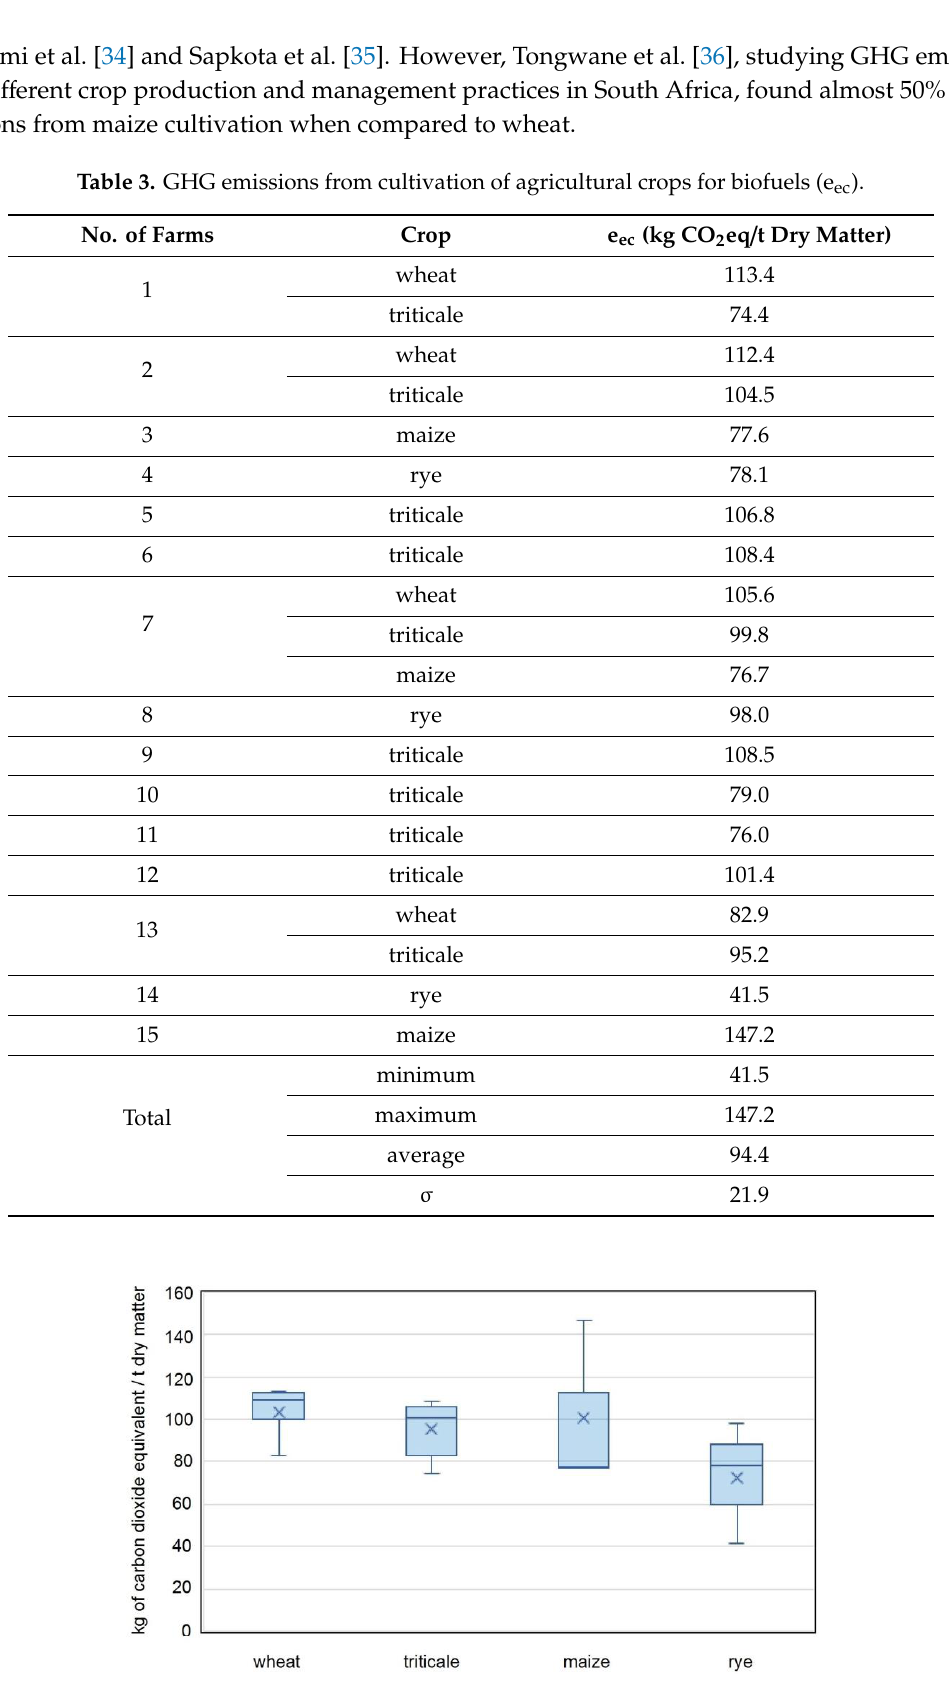
Figure 2. Boxplots presenting the range of GHG emissions from cultivation of agricultural crops for biofuels with average and median.